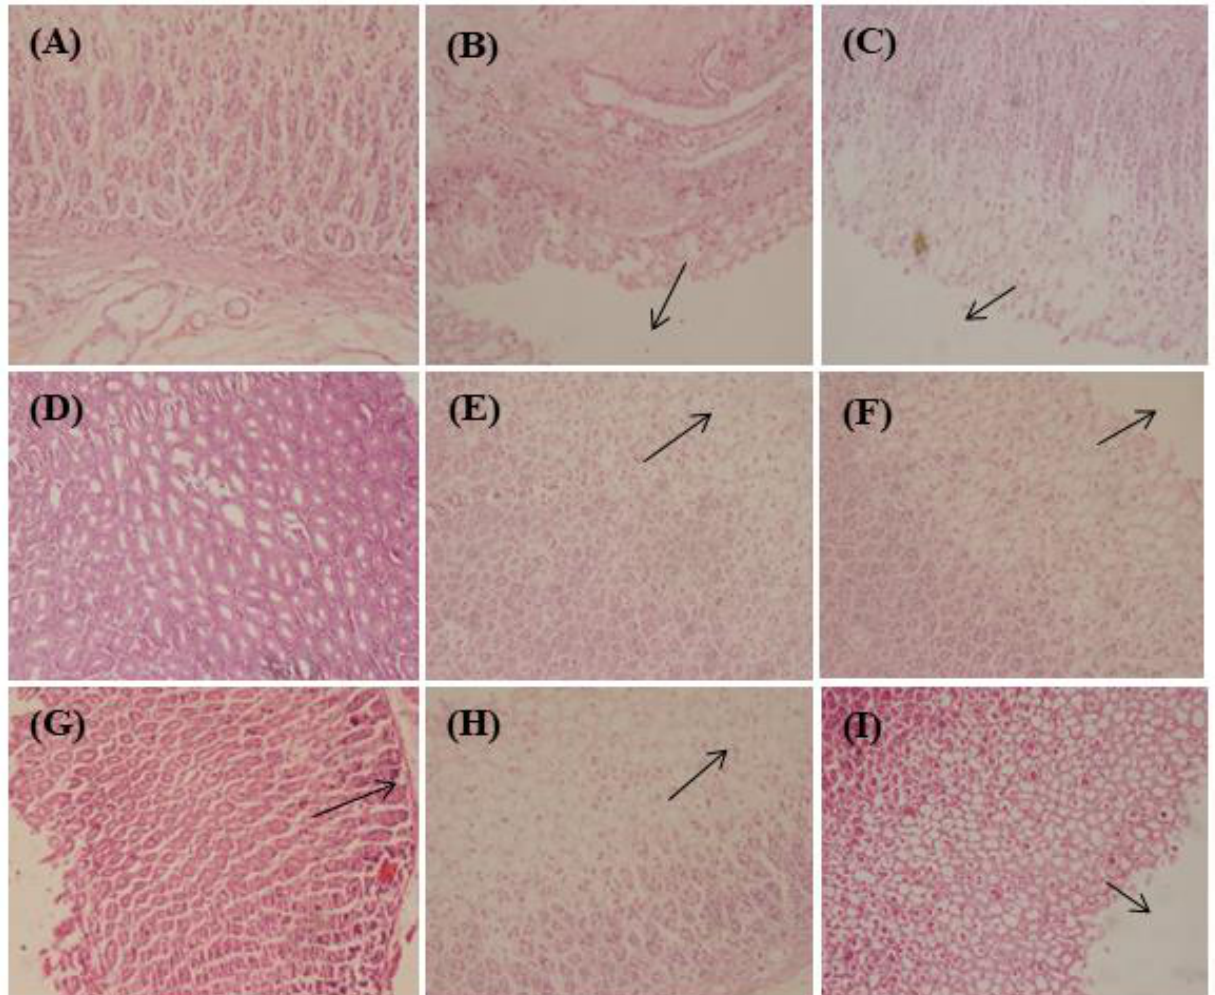
Figure 4. Histopathological examination of stomach mucosa in the acute gastric ulcer model in H. crispum total methanol extract (CME) treated gastric tissues as well as its various fractions; normal group ( A ), disease control ( B ), omeprazole ( C ), CME ( D ), n -hexane ( E ), chloroform ( F ), ethyl acetate ( G ), n- butanol ( H ) and remaining aqueous fraction ( I ) treated groups. Black arrows indicate damage to peptic epithelium.